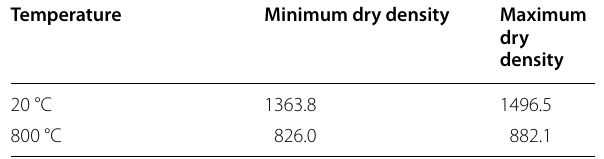
Table 2 Dry density of the samples (kg/m 3 )